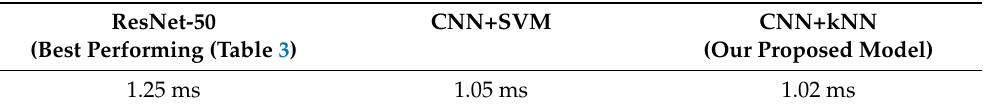
Table 5. Runtime Comparison